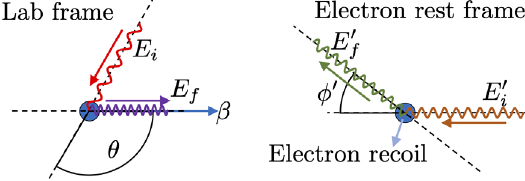
FIG. 2. Illustrations of the ICS geometry in the lab- and electron rest-frames. With the assumptions γ ≫ 1 and θ ≫ 1 = γ , relativ- istic beaming means that we can define the polar scattering angle ϕ 0 relative to the axis of the Lorentz boost.